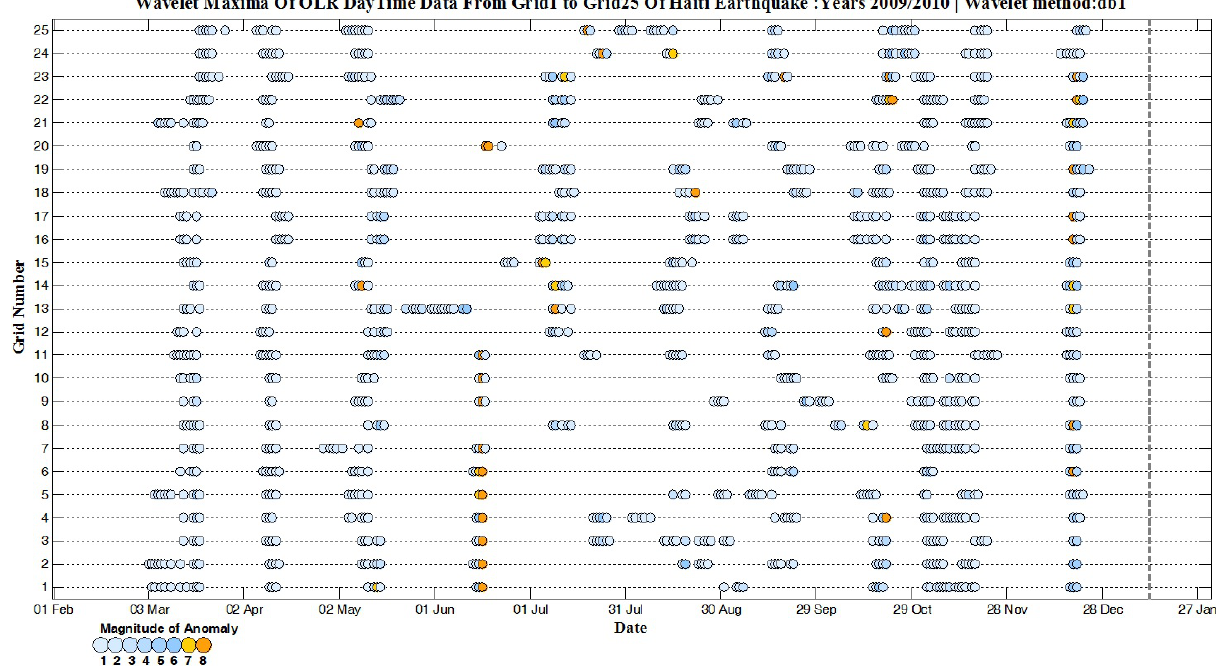
Fig. 5. Wavelet maxima analysis curves from Grid1 to Grid25, with a set of grids of 5 × 5degree of latitude by longitude area over the epicenter, the dashed line indicates the day when the earthquake